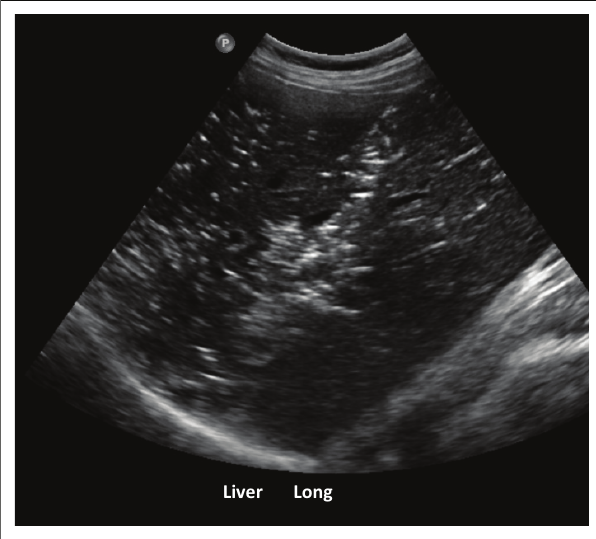
FIGURE 3: Intra-operative view demonstrating a grossly thickened, oedematous terminal ileum with serosal inflammation and omental wrapping.